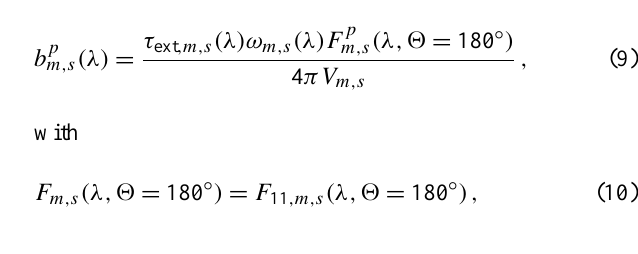
Fig. 2. Range–corrected signal at 1064 nm measured on 29 May 2008, 2147–2315 UTC (signal counts in logarithmic scale). The vertical resolution of the lidar measurement is 60 m, the temporal resolution is 30 s. The 500 nm AOT was 0.7–0.75 up to 6 km height in the evening of 29 May.